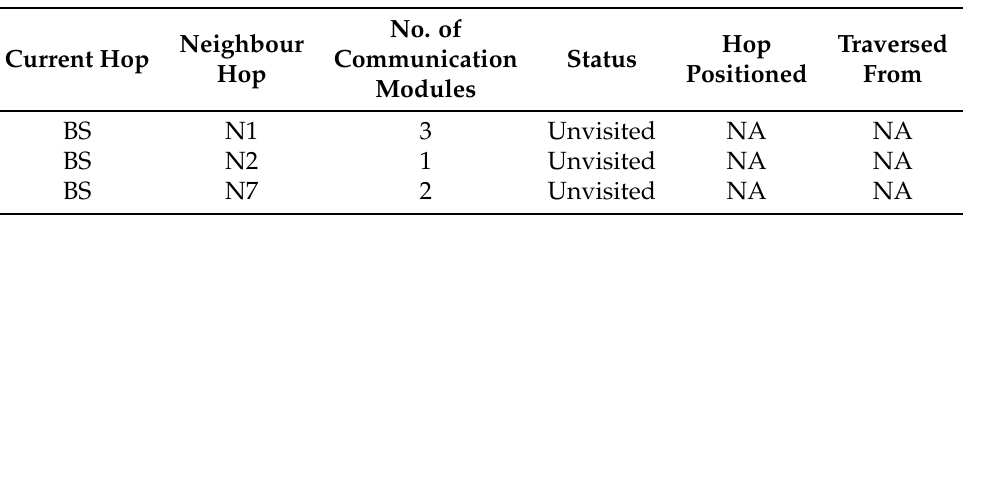
Table 1. The Base Station node BS’s initial tree routing